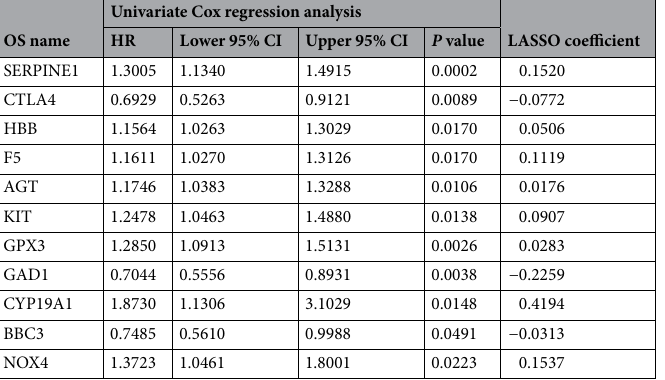
Table 1. Eleven prognosis-associated OS genes with GC in the TCGA dataset were identified by LASSO analysis.